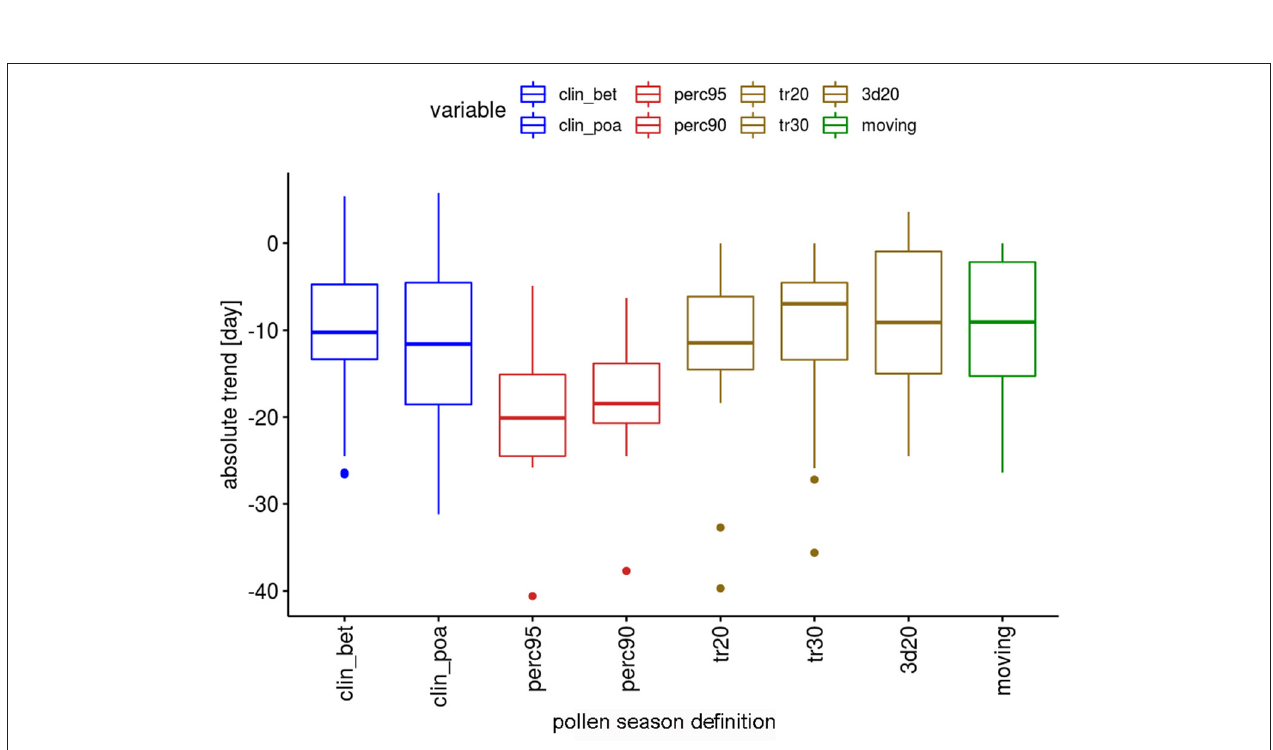
FIGURE 4 | Range of absolute trends [days] for the 50-year period 1969–2018 of the end dates of the pollen season by definition for 12 pollen taxa.